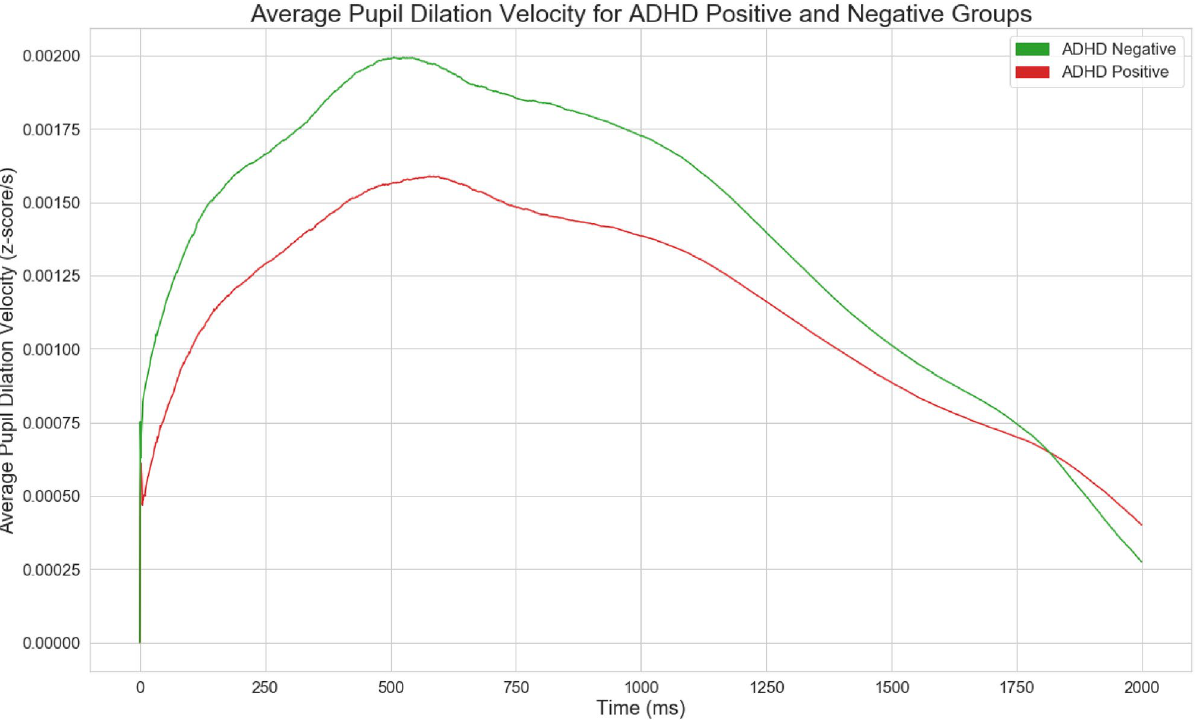
Figure 2. Pupil size dilation velocity following the presentation of a stimulus.